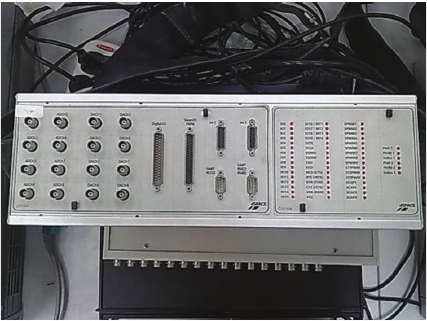
Figure 4: I/O interface board.